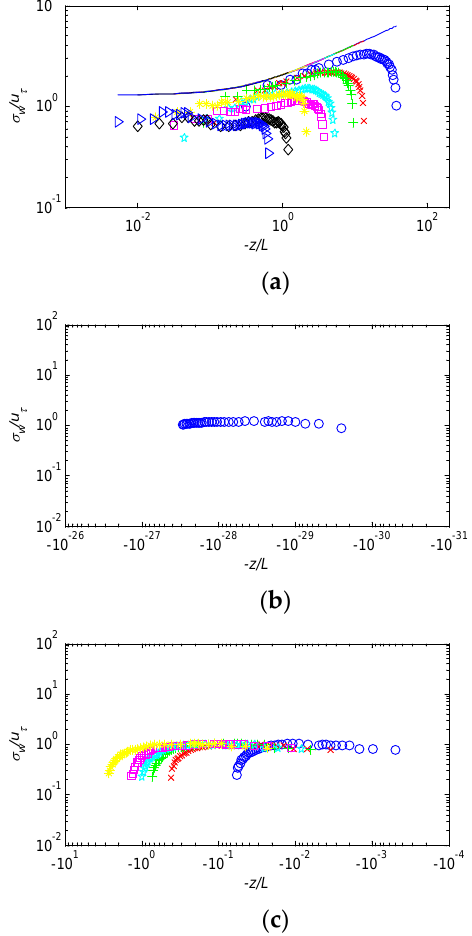
Figure 2. Normalized standard deviation of w ( σ w / u ∗ ) versus − z / L : ( a ) unstable conditions; ( b ) neutral stability conditions; and ( c ) stable conditions. The symbols are the same as in Figure 1, except that the curve in ( a ) now corresponds to Equation (8).